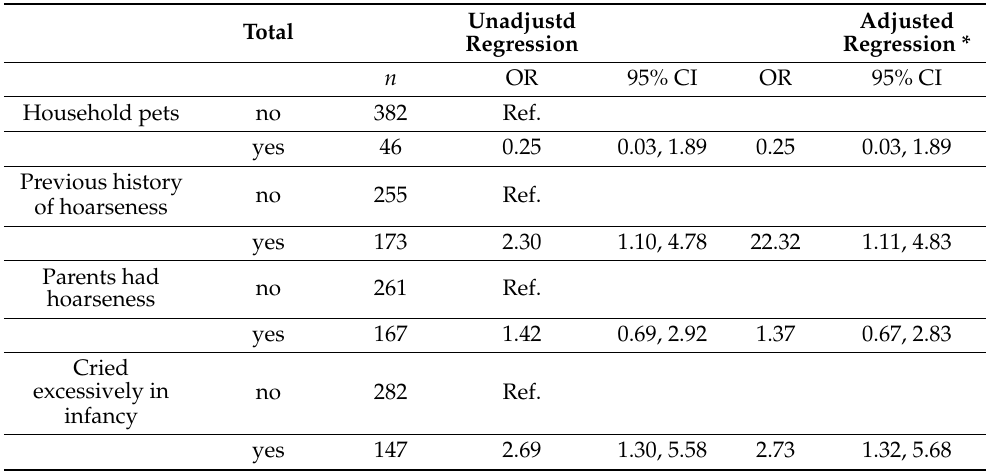
Table 4. Distribution of risk factors of hoarseness and unadjusted and adjusted regressions of hoarseness in relation to these risk